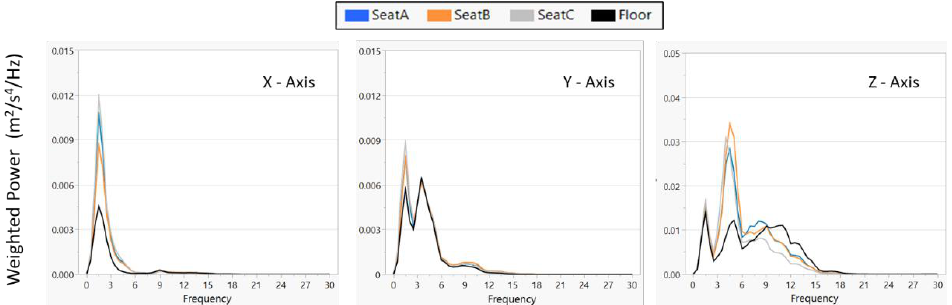
(0.003) (0.002) (0.002) (0.001) (0.006) (0.006) (0.005) Freeway <0.0001 (0.005) The PSD analyses indicated all seats amplified low to mid frequency energy in all three axes for all road segments. The Z-axis was the dominant axis for vibration exposure. As a representative example, Figure 6 shows the weighted PSD curves on the X,Y, and Z axes from the city street segment. The results showed that all the three seats attenuated the Z-axis vibration energy above 9 Hz, as indicated by all three seat lines being below the black line (floor). While all the three seats amplified the Z-axis vibration energy between 2.5 and 8.5 Hz, Seat C attenuated Z-axis vibration energy above 6 Hz more so than the other two seats.